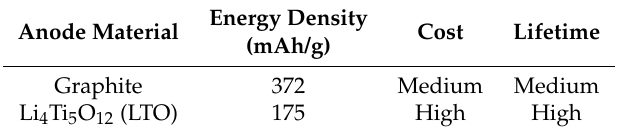
Table 3. Anode materials—Overview including specific energy density, cost and lifetime.